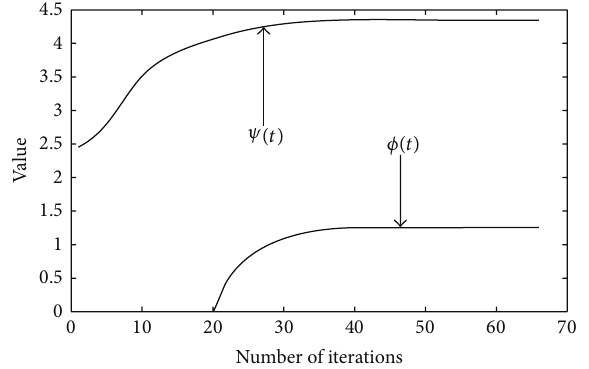
Figure 9: Trajectories of 𝑦(𝑡) = (𝐴 − 𝐴 𝑇 )𝑥(𝑡)/2|𝑏 5 | based on (33) with initial 𝑥(0) as (55), which should converge to the real part of an 5 based on (33) with initial eigenvector of 𝐴 corresponding to the eigenvalue 𝜆 5 . |𝑏 | , respectively. 5 and 5